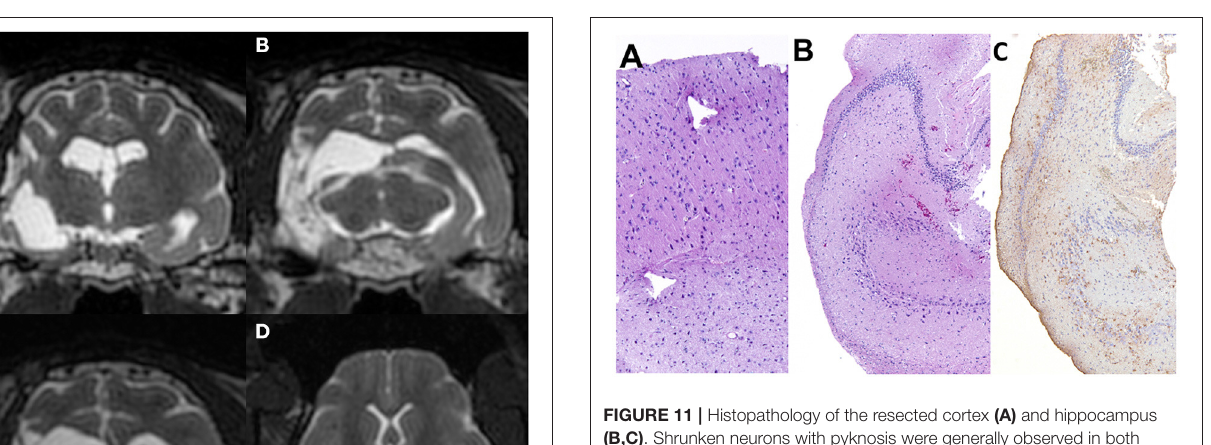
( Figure 9 ). Concurrent MRI revealed complete resection of the right hippocampus and partially resected temporo-occipital